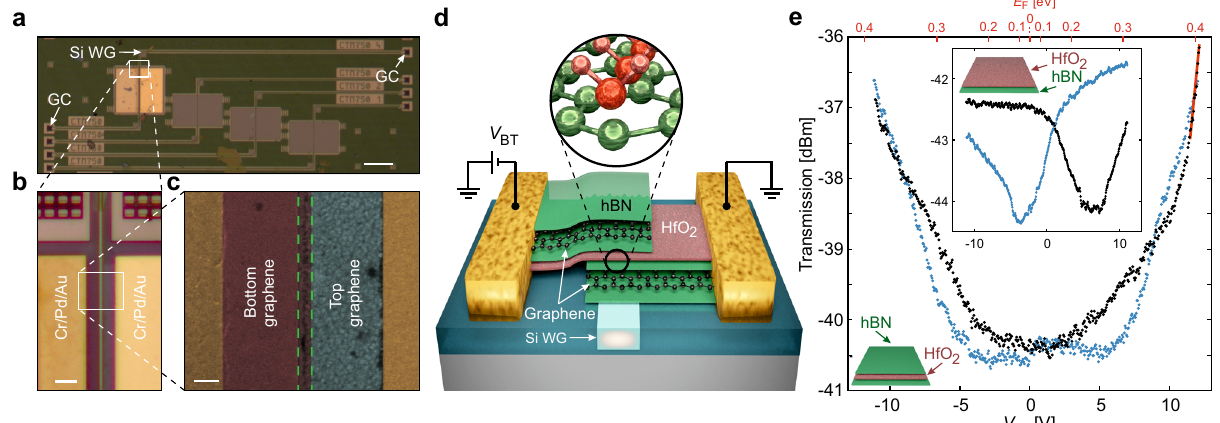
Fig. 1 Device geometry and static characterization. a Optical image of a photonic device consisting of two grating couplers (GC), a silicon optical waveguide (Si WG), and an hBN – HfO 2 – hBN-based graphene EA modulator on top (see zoom-in optical (panel b ) and scanning electron microscope (SEM) (panel c ) images for details). In panel c , the metal contacts are yellow/brown and the bottom and top graphene electrodes violet and light blue, respectively. The core of the waveguide is highlighted by the green dashed lines. The white scale bars in panel a, b, and c are 100, 5, and 1 μ m, respectively. d Electrical connections and schematic cross-section of an EA modulator with an hBN – HfO 2 – hBN dielectric. The top and bottom graphene electrodes are fully encapsulated by hBN (in green) protecting both graphene electrodes from the out-of-plane dangling bonds typical of 3D oxide materials, e.g., HfO 2 (in red). See inset for a molecular representation. e Transmission curves as a function of the voltage between the bottom and top graphene electrodes ( V BT axis, bottom) and the Fermi energy at the graphene electrodes ( E F axis, top) for the EA modulator in panel a with an hBN – HfO 2 – hBN dielectric (see sketch). The 1550 nm excitation power was set to 0 dBm. The forward and backward voltage sweeps (black and blue, respectively) show no major hysteresis compared to a modulator with an hBN – HfO 2 dielectric (see inset). The red line is a linear fi t to the forward voltage sweep within a 0.5 V voltage span (extracted slope: 2.2 dBV − 1